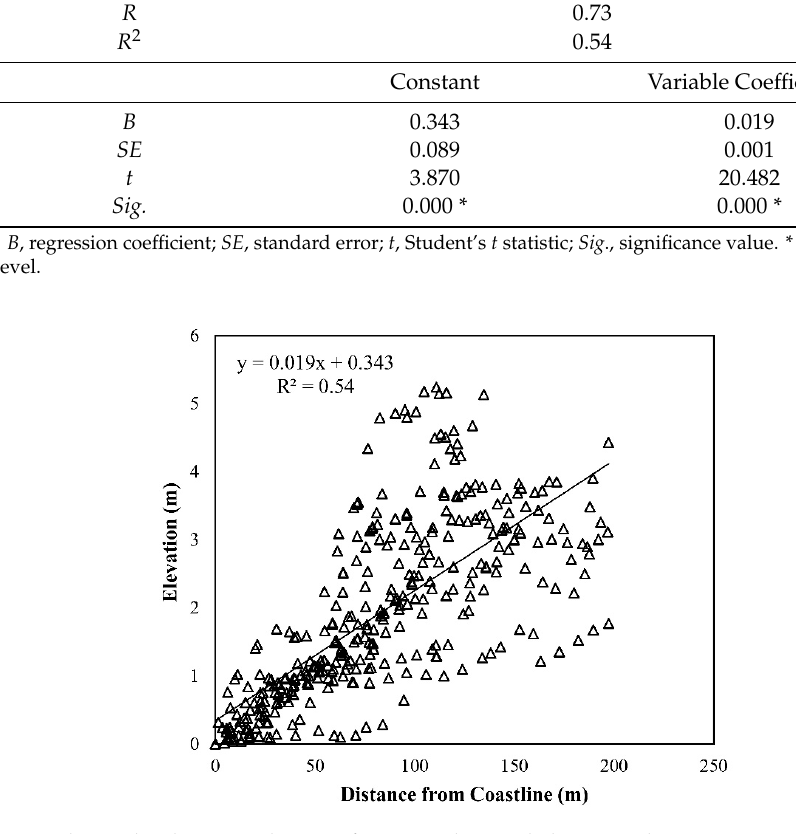
Figure 4. Relationship between distance from coastline and elevation above mean sea level ( n =